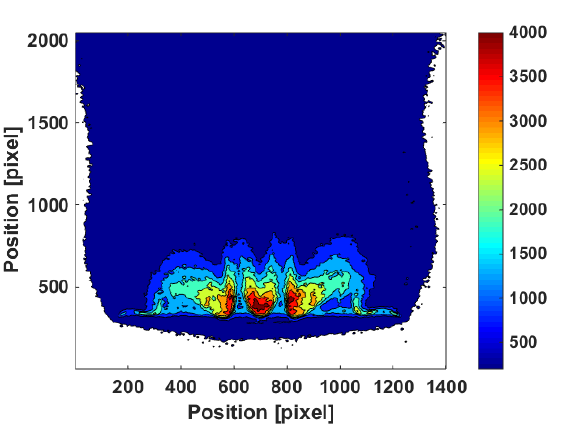
Fig. 14. C 10880-03, 60% gain, exposurer time 300µs, contours of median smoothed image